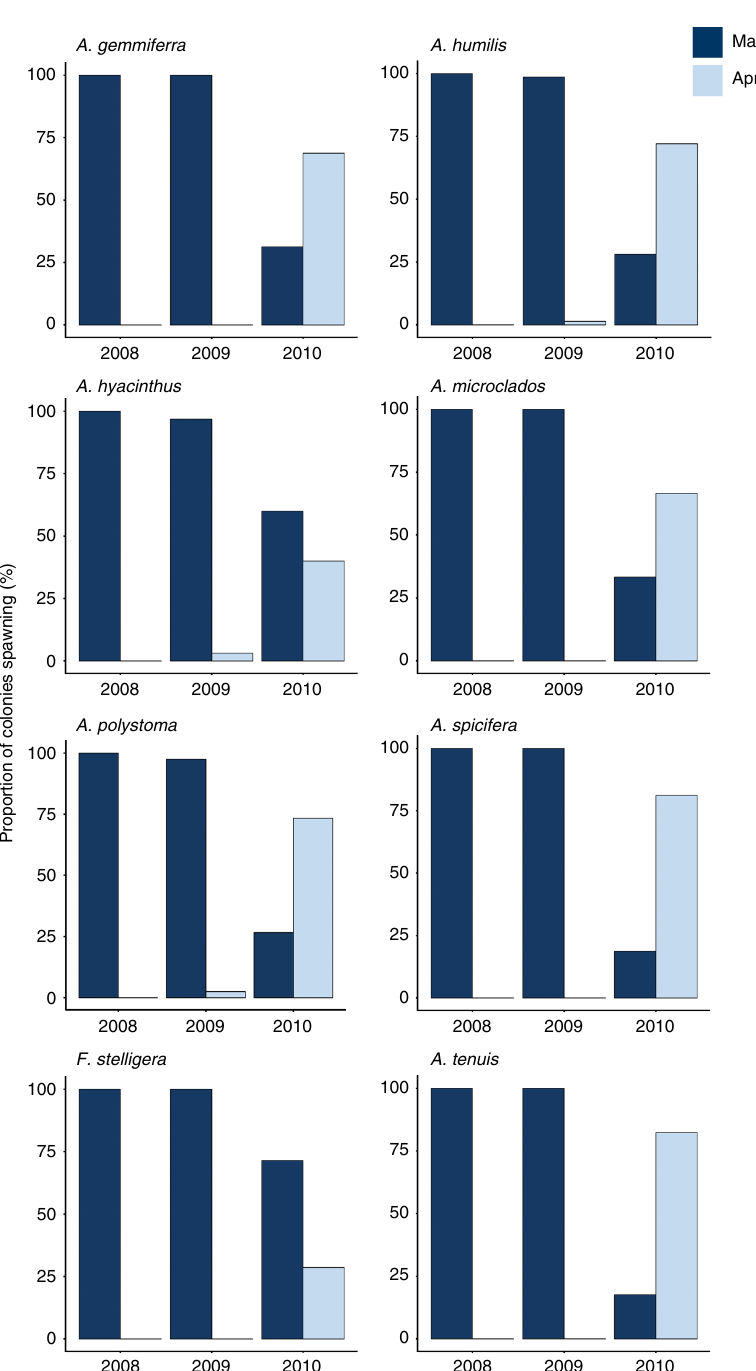
Fig. 4 Proportions of corals spawning in autumn at Scott Reef from 2008 to 2010. Bars show the proportion of coral colonies spawning in March versus April in mass spawning years in 2008 and 2009, compared to a split spawning year in 2010 at Scott Reef. Proportions are for eight coral species and the sample sizes for each species and year are presented in Supplementary Table Field samples . Eight species of scleractinian coral ( Acropora gemmiferra , Acropora 6-month temperature anomalies . Corals at Scott Reef typically take 4 – 6 months humilis , Acropora hyacinthus , Acropora microclados , Acropora polystoma , Acropora to undergo gametogenesis 25 . Temperatures during these months could impact rates spicifera , Acropora tenuis and Favia stelligera ) were sampled from up to six sites at of gametogenesis and subsequently, spawning date. To investigate whether split Scott Reef. Approximately (median) 16 replicate colonies were sampled per species, spawning events were driven by seawater temperature anomalies, the sum of the per year, but sample sizes varied among species and years (see Supplementary temperature anomalies for the 6 months prior to spawning were calculated. Table 3 for sample sizes). Colonies were sampled 2 to 5 weeks prior to the predicted Extended Reconstructed Sea Surface Temperature (ERSST v5) records for Scott Reef mass spawning dates in autumn (March/April) in 2008 and 2009 (mass spawning from NOAA were used to determine mean monthly temperatures from 2007 to 2015 years) and 2010 (split-spawning year). Only sexually mature (>20 cm diameter) (2016 was excluded because no spawning occurred due to mass coral bleaching). The colonies were sampled and three branches were collected from each colony. monthly means were compared to the extended monthly means (1854-2015) also Branches were collected from the centre of the colony to avoid sterile colony derived from ERSST v5 (NOAA), to determine the anomaly for each month.